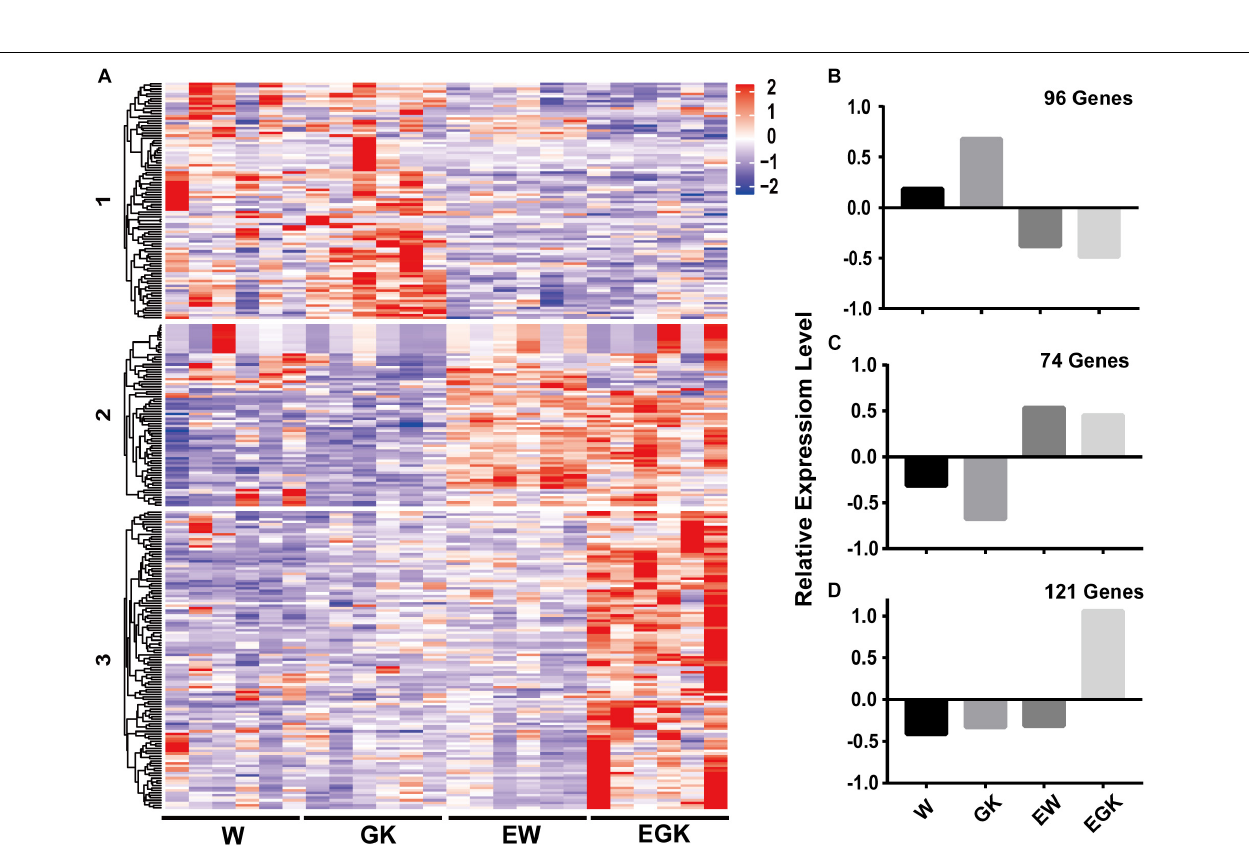
FIGURE 5 | The expression patterns of DEGs of exercise GK in the four groups. DEGs in the exercise GK rats were analyzed using k -means clustering method. This identified three major groups, presented in heat map based on patterns of expression (A) , and graphical format based on the mean value of z -score values of gene expression in cluster 1 (B) , cluster 2 (C) , and cluster 3 (D)